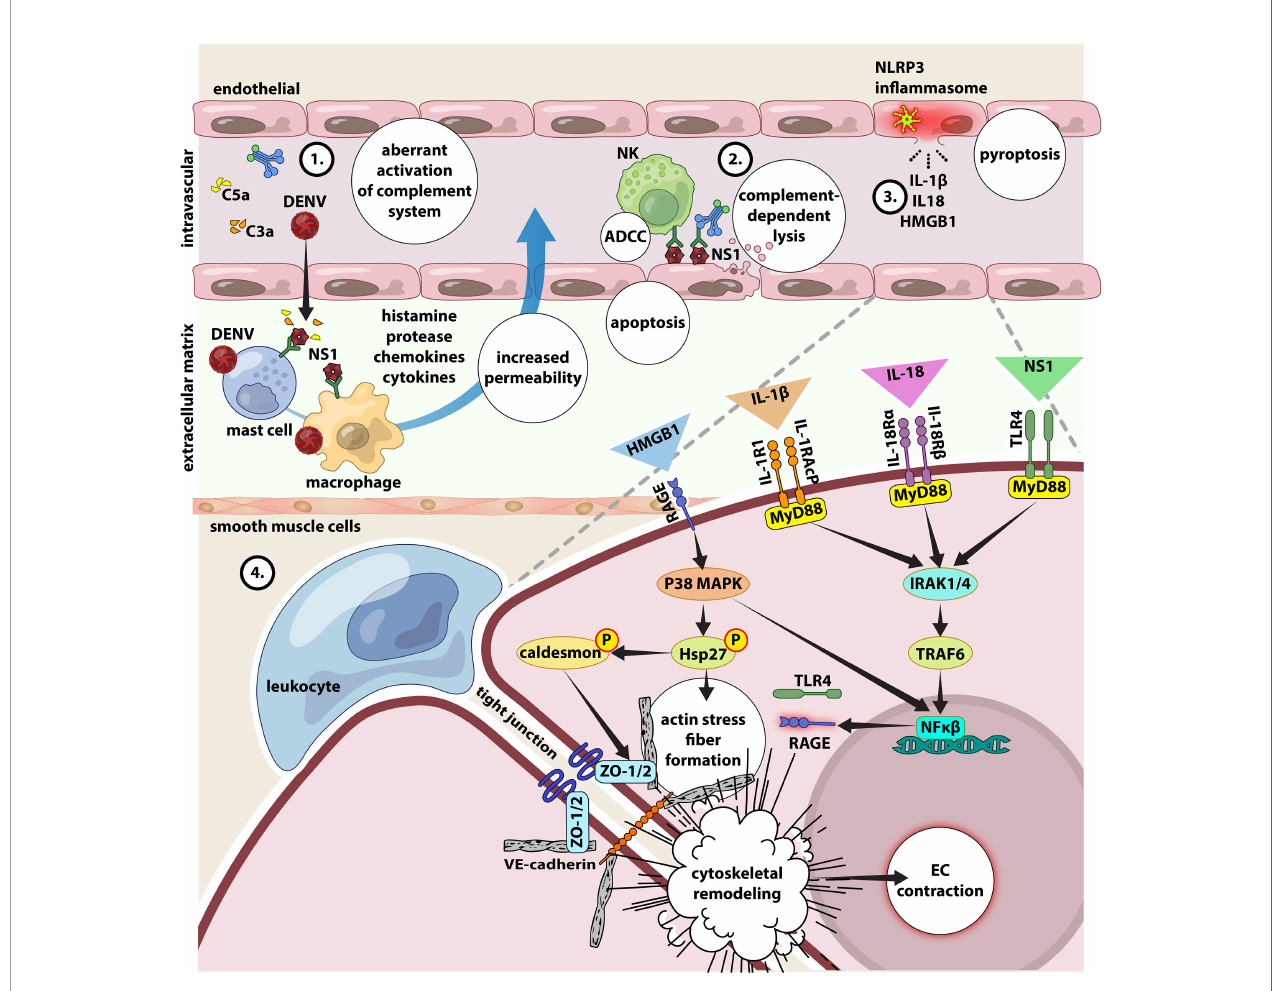
FIGURE 4 | Interplay between NS1, in fl ammasome activation, complement activation, autoreactive antibodies and cytokine storm in endothelial dysfunction. 1) DENV and NS1 can directly activate CS, the excessive conversion of C3, C4 and C5 to their active forms C3b, C4b and C5b will inevitably cause increased level of C3a, C4a and C5a (anaphylatoxin). Large amount of anaphylatoxin will cause aberrant activation of mast cells and release massive amount of histamine, along with other pro-in fl ammatory cytokines, leading to increase of the vascular permeability and vascular leakage. 2) anti-NS1-speci fi c IgM and IgG have been found circulating in the blood stream forming immune complexes with the both forms of NS1 proteins. While mNS1 is expressed on DENV infected cells, the circulating sNS1 can subsequently bind to surface of infected or uninfected cells via heparan sulfate and chondroitin sulfate E (90). These antibodies will then bind to NS1 and leading complement-dependent lysis of cell and antibody-dependent cellular cytotoxicity, damaging the endothelial layer and leading to vascular leakage (47). 3) Secretion of IL-1 b , IL-18 and HMGB1 results from NLRP3 in fl ammasome activation. 4) In the circulation, IL-1 b and IL-18 binds to their cognate receptors (IL-1R1/acP and IL- 18R a / b ) expressed on the surface of endothelial cells to activate intracellular signaling molecules, involving MyD88, IL-1 receptor-associated kinase 1/4 (IRAK1/4), and TNF receptor-associated factor (TRAF), which entails in NF- k B activation. NS1 can also activate the NF- k B signaling pathway via TLR4. The activation of NF- k B signaling pathway increases the secretion of pro-in fl ammatory cytokines and chemokines to mediate leukocyte adhesion and extravasation (diapedesis). Additionally, the binding of HMGB1 to the RAGE receptor leads to the downstream activation of p38 MAP kinase, resulting in phosphorylation of the actin-binding protein Hsp27 and caldesmon, which causes actin stress fi bers to form, cytoskeletal remodeling, and endothelial contraction. All these reactions increase endothelial permeability by altering cell contractility and disruption of intercellular junctions. Given the ability of IL-18 to induce the production of various pro-in fl ammatory mediators including TLR4 and RAGE via activation of NF k -B signaling (75, 91, 92), their higher expression will condition the endothelial cells to be more responsive to stimulation by NS1 and HMGB1, to further magnify in fl ammation and vascular